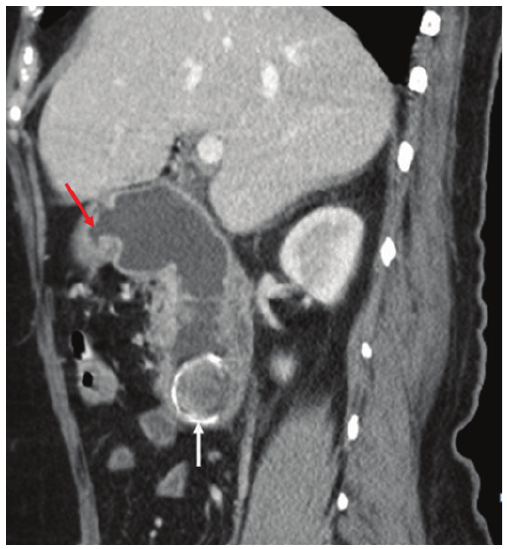
Figure 2: Sagittal reformatted MDCT image shows the fistula (red arrow) lying anteriorly and the calculus (white arrow) with a hyperdense rim.